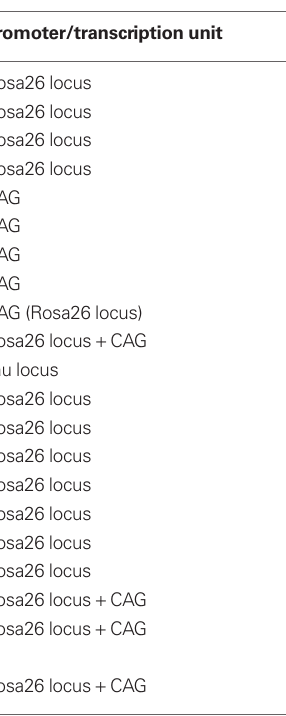
Table 2 | Site-specific recombinases (SSRs)-responsive effector